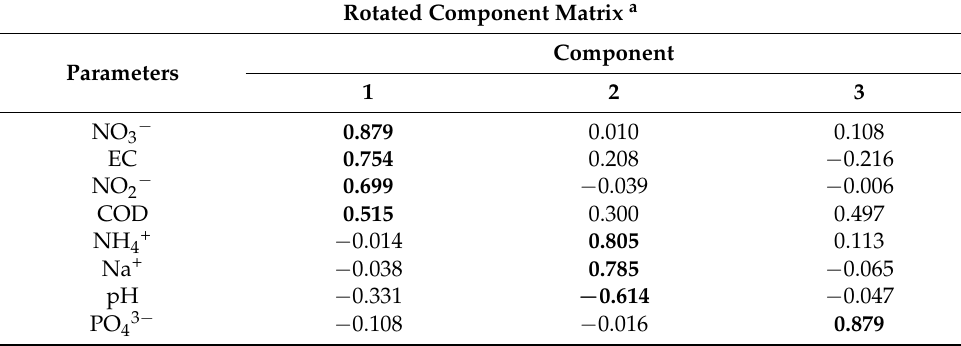
Table 2. Rotated component matrix of the variables.